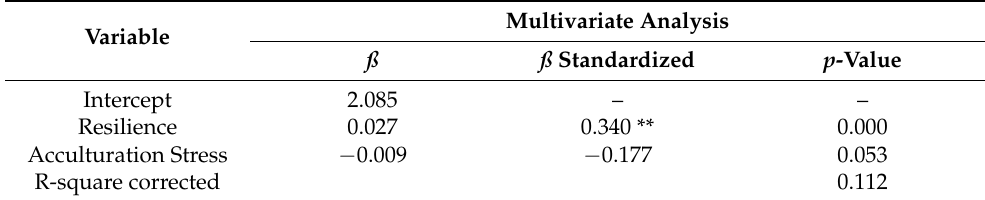
Table 5. Factors associated with integration and social competence in the secondary